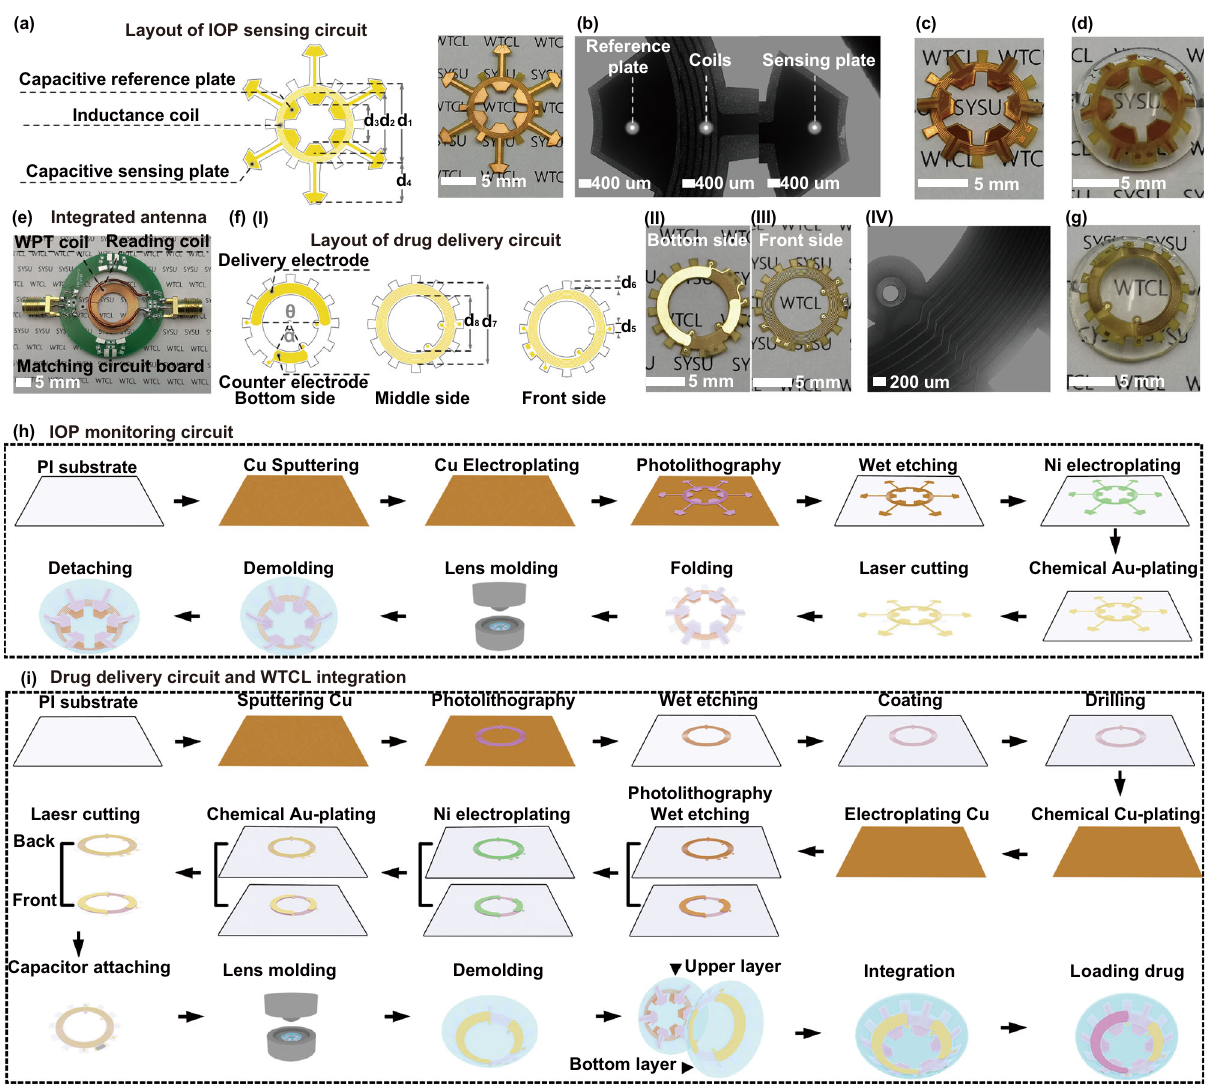
Fig. 2 Schematic illustration of the WTCL ’ s design and fabrication process. a The snow fl ake-shaped layout design and the photograph of the sensing circuit. b The microscopic image of the reference plate, coils, and sensing plate deployed on the sensing circuit. The photograph of ( c ) the folded sensing circuit and ( d ) the upper layer of contact lens. e Image of the integrated antenna. f (I) The fl ower-shaped layout design, (II) bottom surface, (III) front surface images, and (IV) microscopic image of the drug delivery circuit. g The photograph of the bottom layer lens integrated with the drug delivery circuit. Illustration of the fabrication process of ( h ) IOP monitoring circuit, i drug delivery circuit and the device integration. The fabrication of the sensing and delivery modulus employed a printed circuit process coupled with a cast-molding